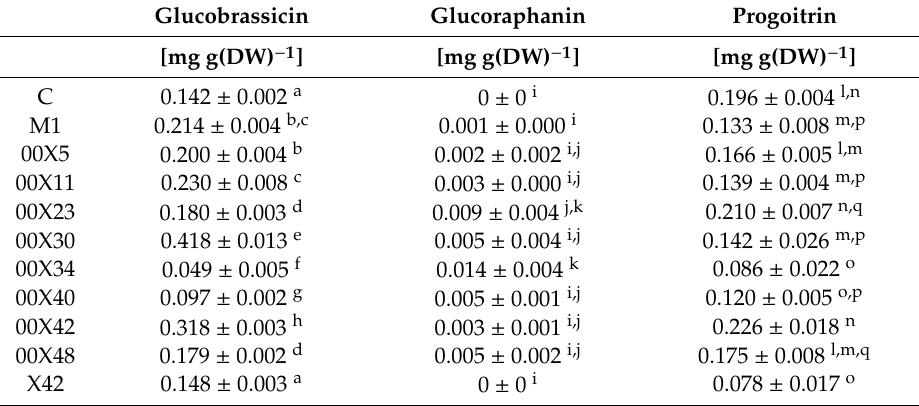
Table 3. The contents of glucosinolates in the rapeseed leaves. Each code (00X5, 00X11, 00X23, 00X30, 00X34, 00X40, 00X42, 00X48, X42, and M1) represents rapeseed plants treated with a Pythium strain. Control (C) was prepared as untreated rapeseed plants. The di ff erent letters in upper index denote significant di ff erences ( p ≤ 0.05) between groups according to one-way ANOVA (Bonferroni method). Abbreviations: DW, dry